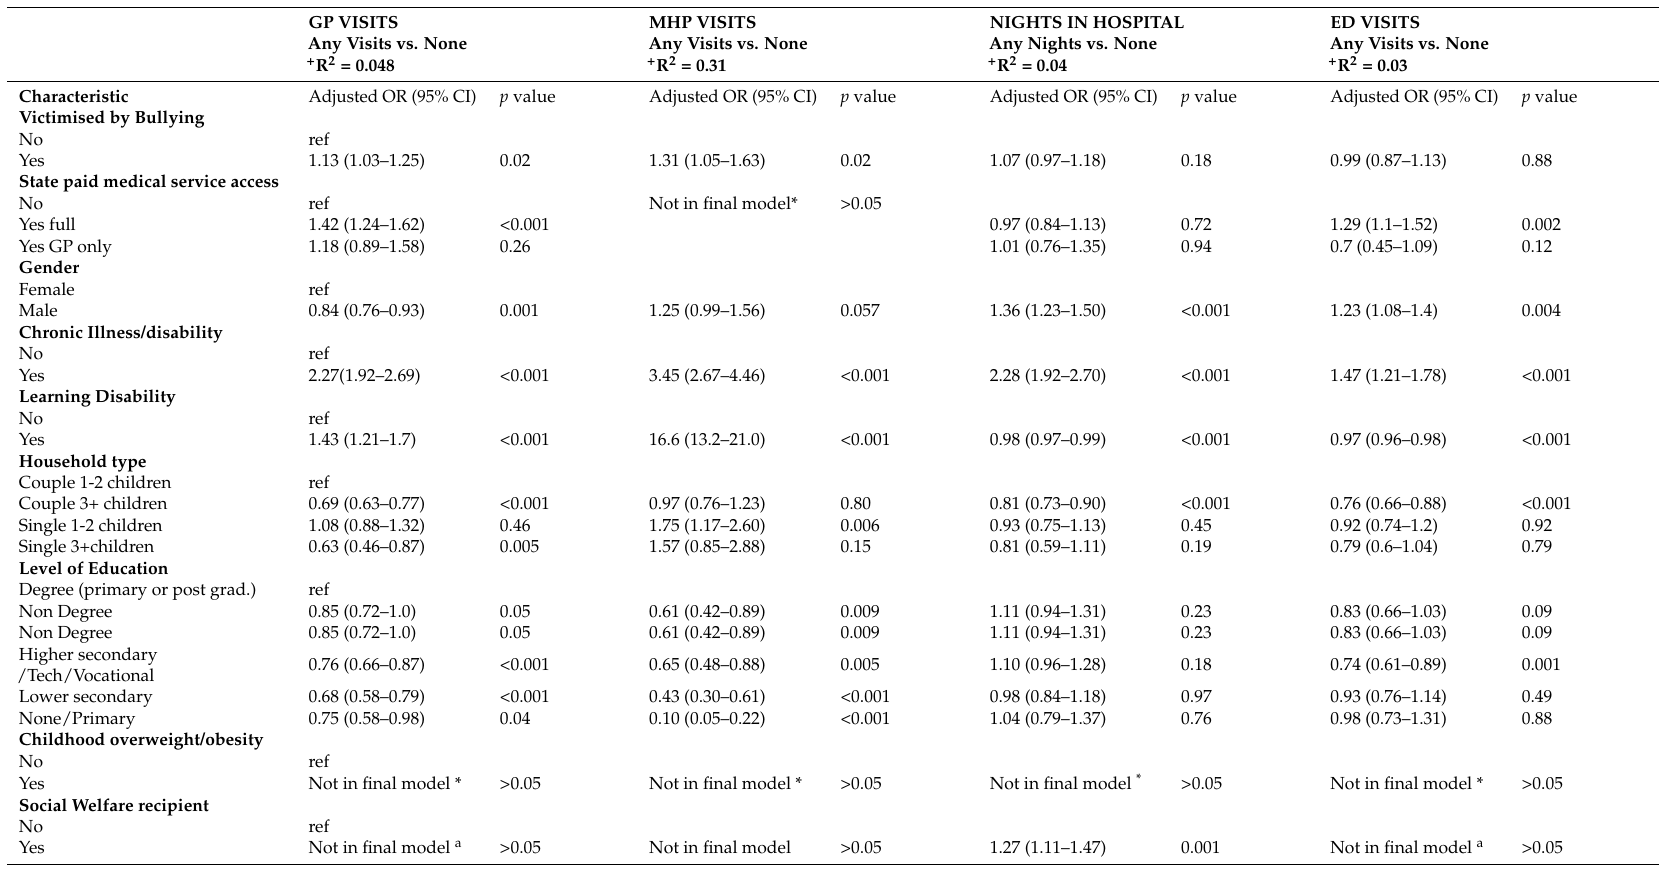
Table 3. Logistic regression models of bully victimisation and